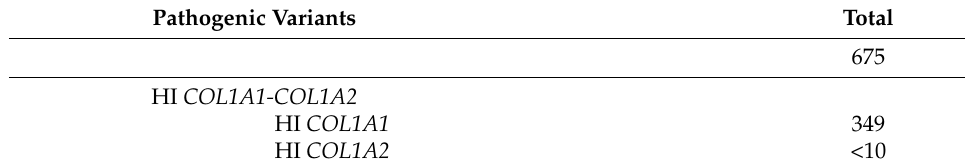
Table 1. Pathogenic variants identified in the Dutch Osteogenesis Imperfecta